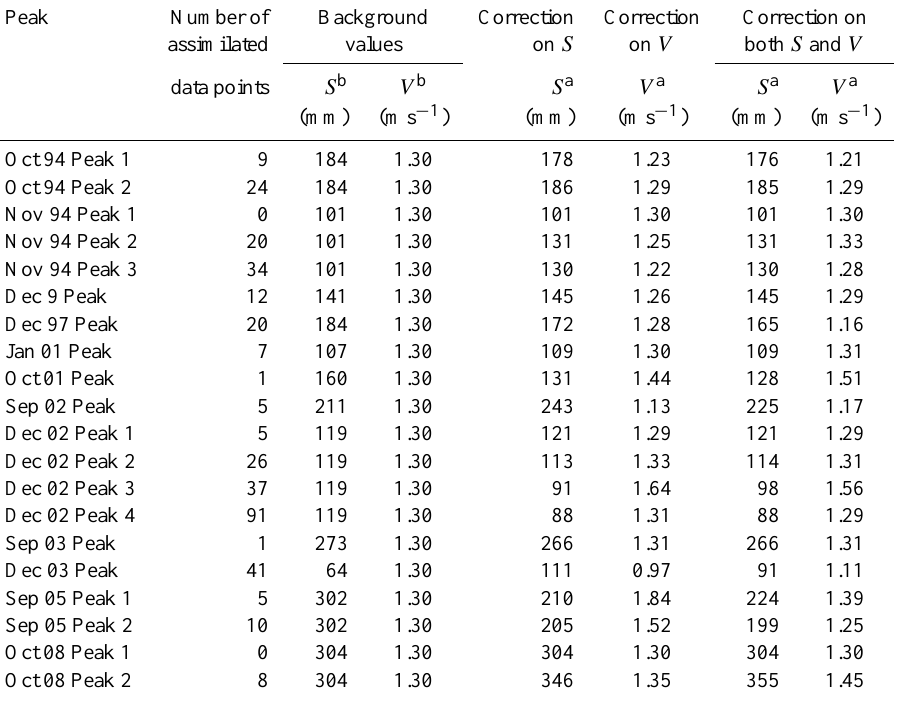
Table 2. Values of the parameters S and V before (background) and after (analysis) correction with discharge assimilation and number of data assimilated. S b , V b : background value; S a , V a : analysis